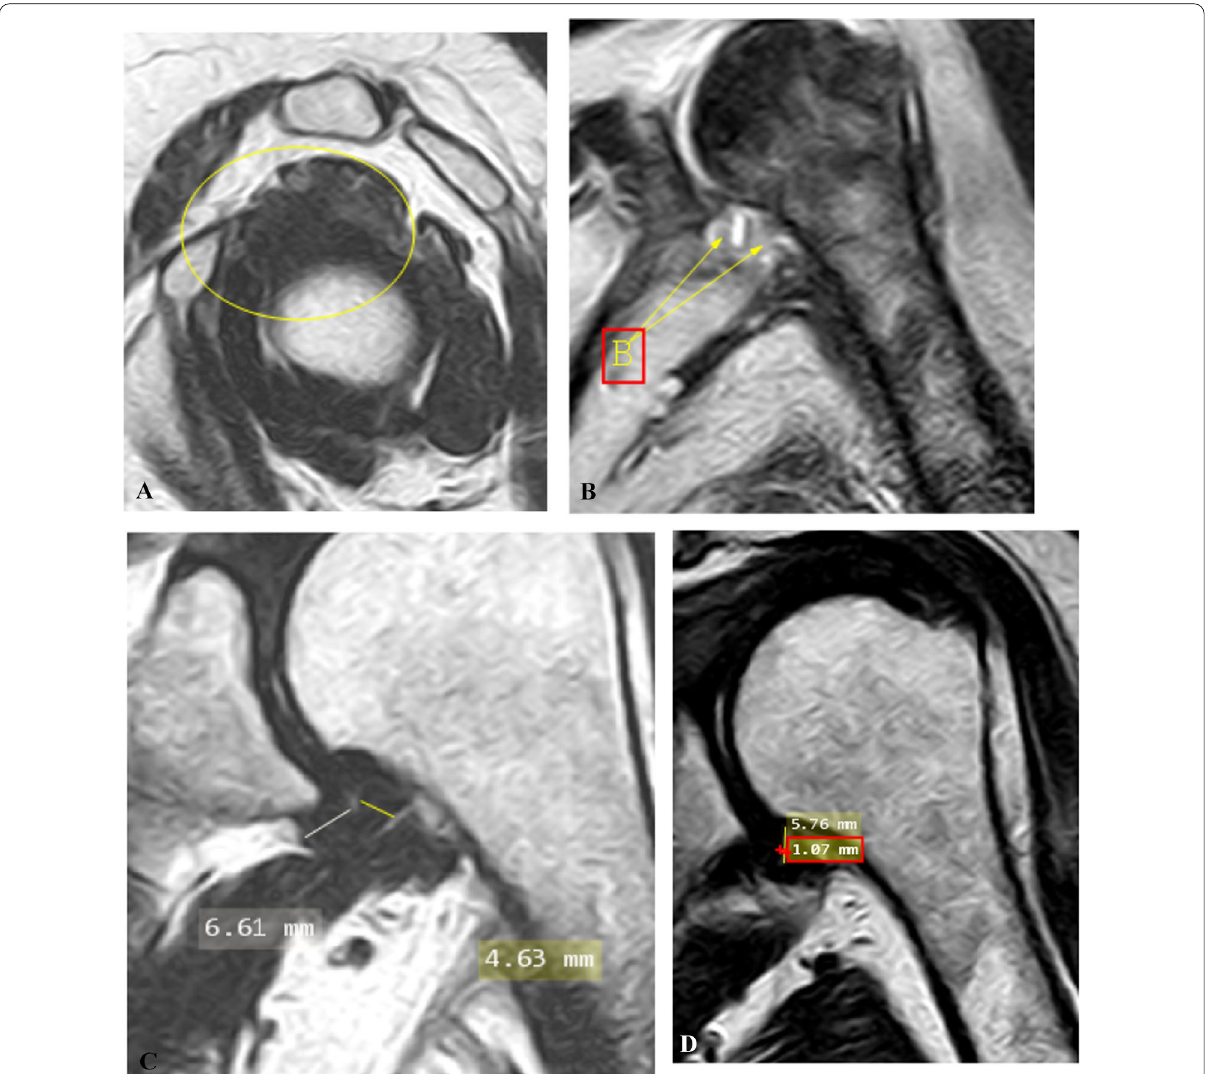
Fig. 6 A Oblique sagittal T2-weighted MR image shows complete obliteration of subcoracoid fat triangle with no observed fat planes or coracohumeral ligament (encircled area). B Oblique coronal fat-suppressed PD-weighted MR image shows edema at glenoid and humeral portions of axillary recess (arrows). C Oblique coronal T2-weighted MR image shows measurement of thickest portion of joint capsule in humeral and glenoid portions of axillary recess. D Oblique coronal T2-weight MR image shows measurement of maximal height and width of axillary recess